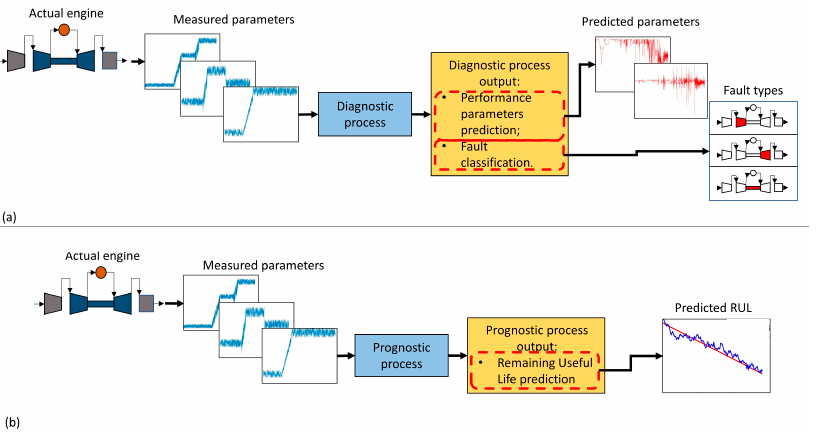
Figure 10. Diagnostic and prognostic processes illustration. ( a ) Overview of a diagnostic process; ( b ) Overview of a prognostic process.